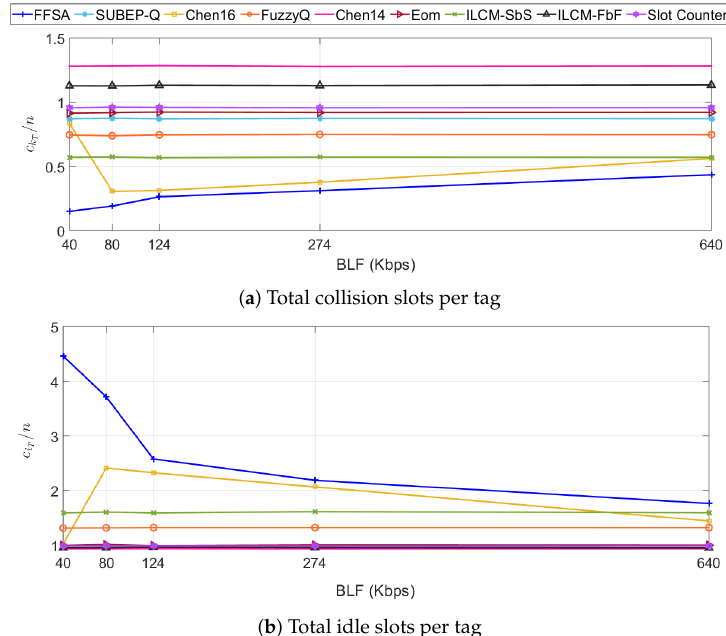
Figure 7. Evaluation results of c k